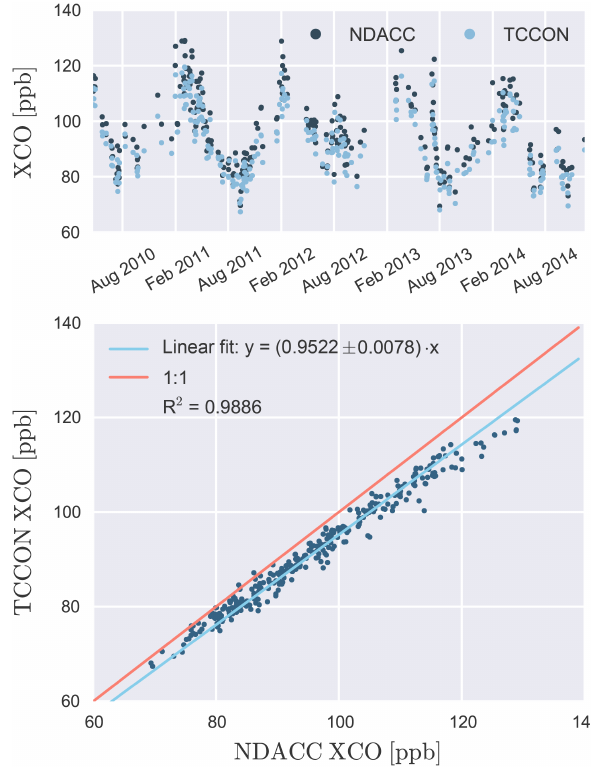
Figure 8. Upper panel: daily mean time series of XCO retrieved from MIR and NIR spectra using the NDACC and TCCON retrieval strategy respectively; lower panel: scatter graph of NDACC and TC- CON daily means. The slope was obtained from a linear fit forced through